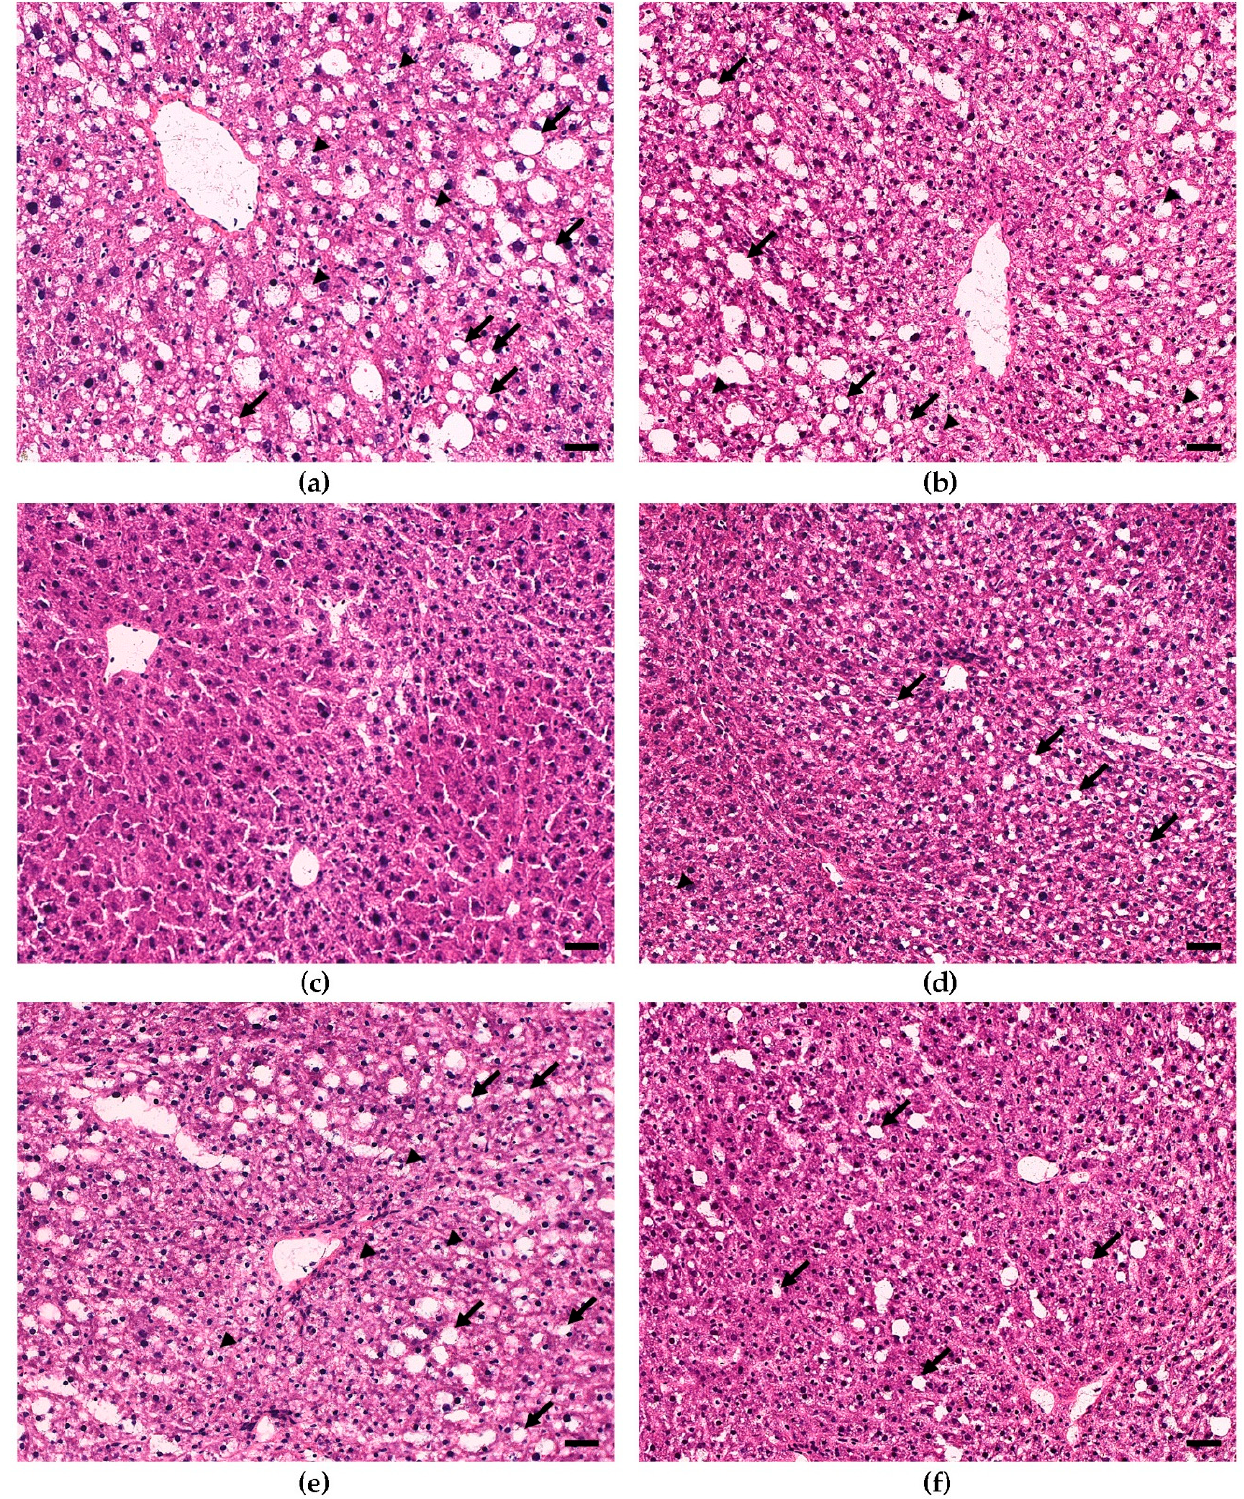
Figure 2. Comparison of lipid accumulation in male and female H&E-stained liver sections across different diets. ( a ) Male 0%; ( b ) Female 0% bean; ( c ) Male 70% bean; ( d ) Female 70% bean; ( e ) Male low fat; ( f ) Female low fat. Steatosis (arrows); hepatocyte ballooning (arrowheads); magnification 200×; bars = 40 µm.